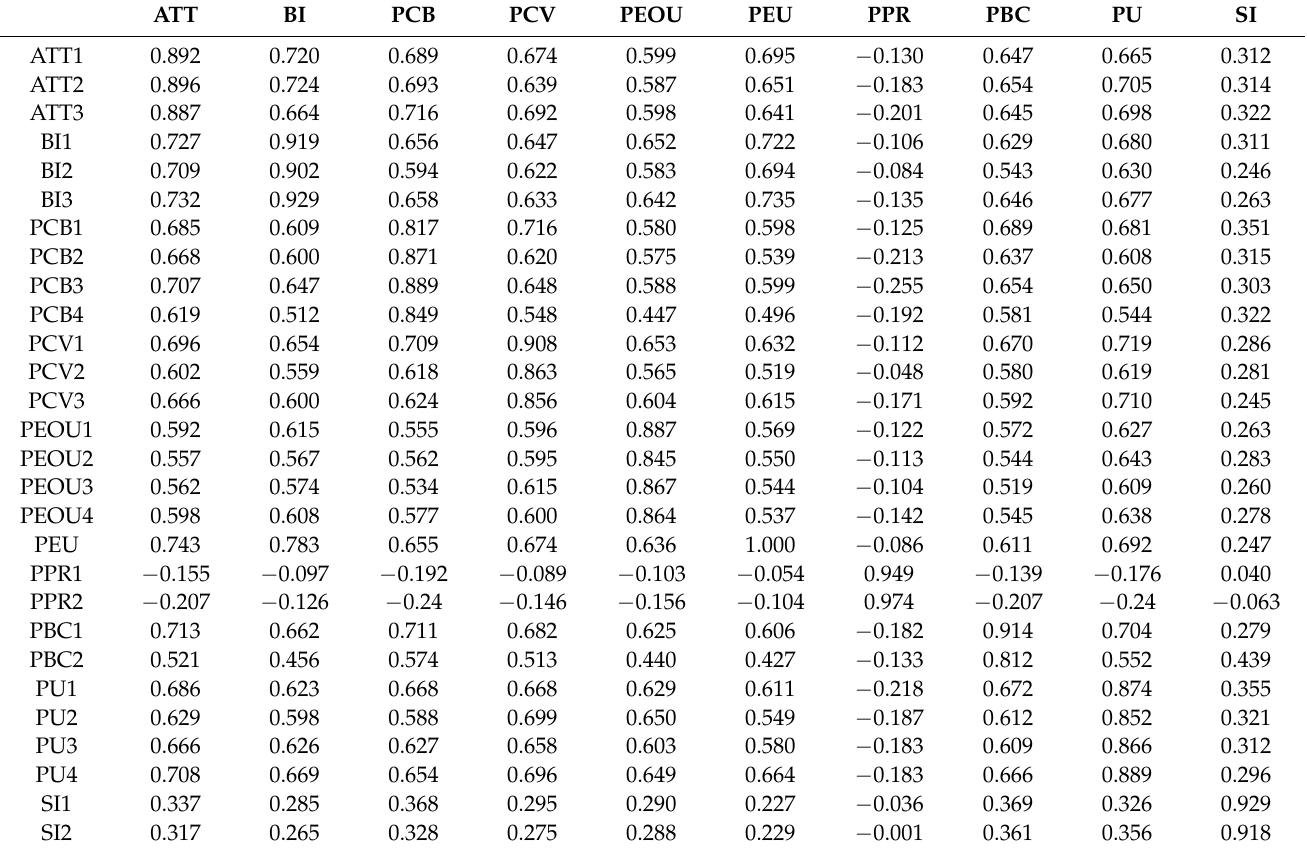
Table 6. Matrix of outer loadings and cross-loadings of the measurement